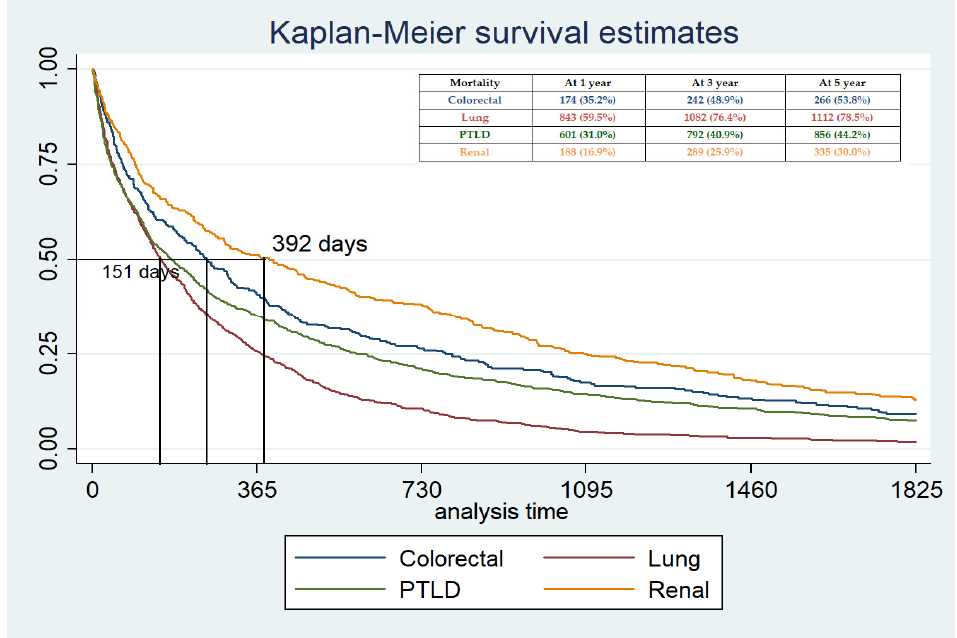
Figure 3. Patient survival time from the date of diagnosis.